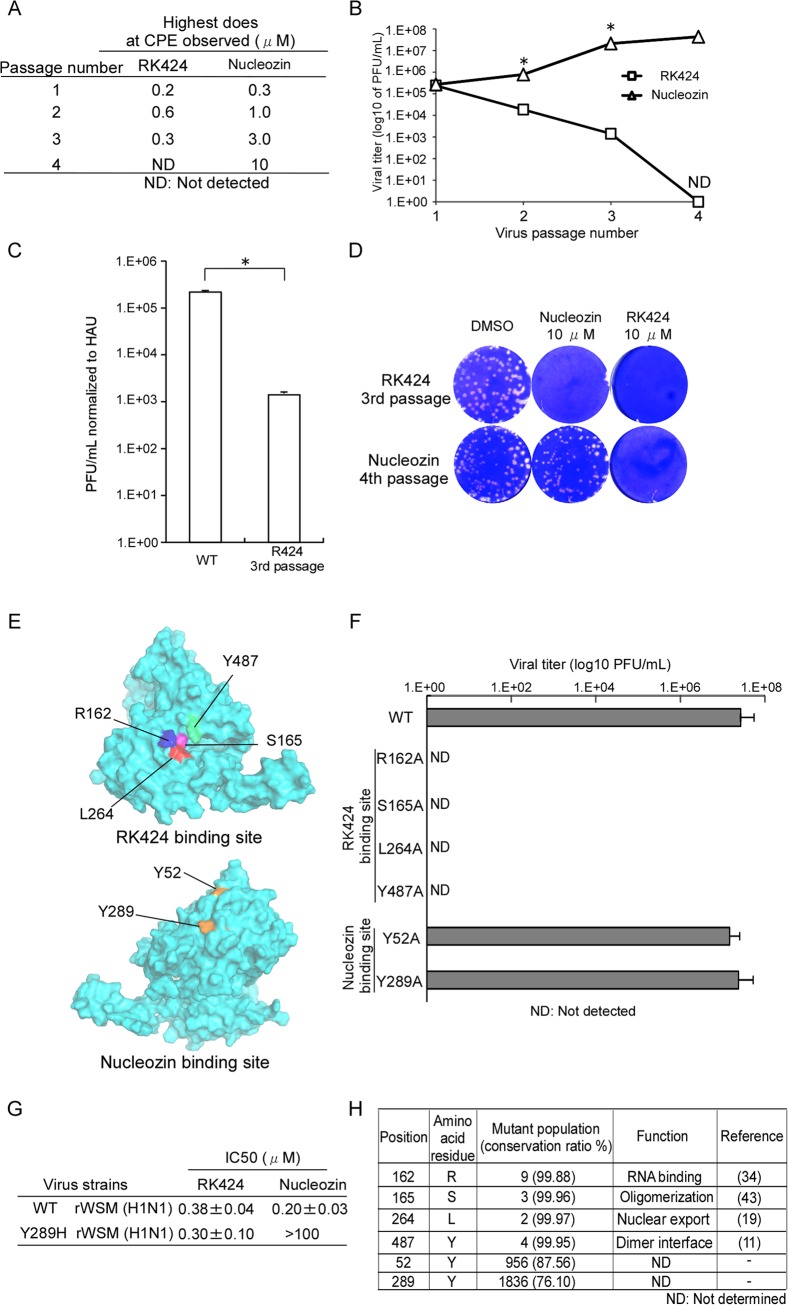
Production of mutant viruses and conservation of amino acids at RK424 and nucleozin binding sites.(A) In vitro selection of escape viruses in the presence of serial dilutions of RK424 and nucleozin. RK424 concentration range: 1st; 0.1–2 μM, 2nd; 0.2–3 μM, 3rd; 0.3–3μM and 4th; 0.4–3 μM. Nucleozin concentration range: 1st; 0.1–2 uM, 2nd; 0.3–3 μM, 3rd; 1–5μM and 4th; 3–10 μM. The highest concentrations of compound that elicited CPE at each passage are listed. (B) Plaque titration of escape viruses in each passage. Values represent the mean ± SD of three independent experiments. The symbol (*) indicates statistically significant differences in mean viral titer (PFU/mL) between RK424 passaged virus and nucleozin passaged virus at each passage number.*;p<0.001. (C) Viral titer of RK424 3rd passaged virus and nucleozin 4th passaged virus stocks normalized to absolute virion numbers (based on hemagglutination units; HAU). Values represent the mean ± SD of three independent experiments. *;p<0.005. (D) Sensitivity of RK424- and nucleozin-selected viruses to DMSO (left well), 10 μM nucleozin (middle well) and 10 μM RK424 (right well). Two independent experiments were performed and one representative result is shown. (E) Models showing the binding sites on NP targeted by RK424 and nucleozin. (F) Production of recombinant viruses harboring R162A, S165A, L264A, Y487A, Y52H, and Y289H mutations in NP. HEK293T/MDCK cells were transfected with plasmids expressing four viral proteins (PB2, PB1, PA, and NP) and eight vRNAs (PB2, PB1, PA, HA, NP, NA, M, and NS). Plasmids expressing mutant NP proteins and genomes were used as a substitute for the WT plasmid when generating the R162A, S165A, L264A, Y487A, Y52H, and Y289H NP mutant viruses. After 72 h of transfection, supernatants were harvested and used in plaque assays on MDCK cells. Data are expressed as the mean ± SD of three independent experiments. (G) The 50% inhibitory concentration (IC50) of RK424 and nucleozin against rWSN and Y289H rWSN viruses were evaluated in a plaque assay in the absence or presence of RK424 and nucleozin (0–100 μM). Data are expressed as the mean + SD of three samples in each of three independent experiments. (H) Conservation of RK424 binding sites (R162, S165, L264, and Y487) and nucleozin binding sites (Y52 and Y289) in human, avian, and swine influenza A viruses. Perl script was used to analyze 7683 NP sequences derived from human, avian, and swine influenza A viruses.